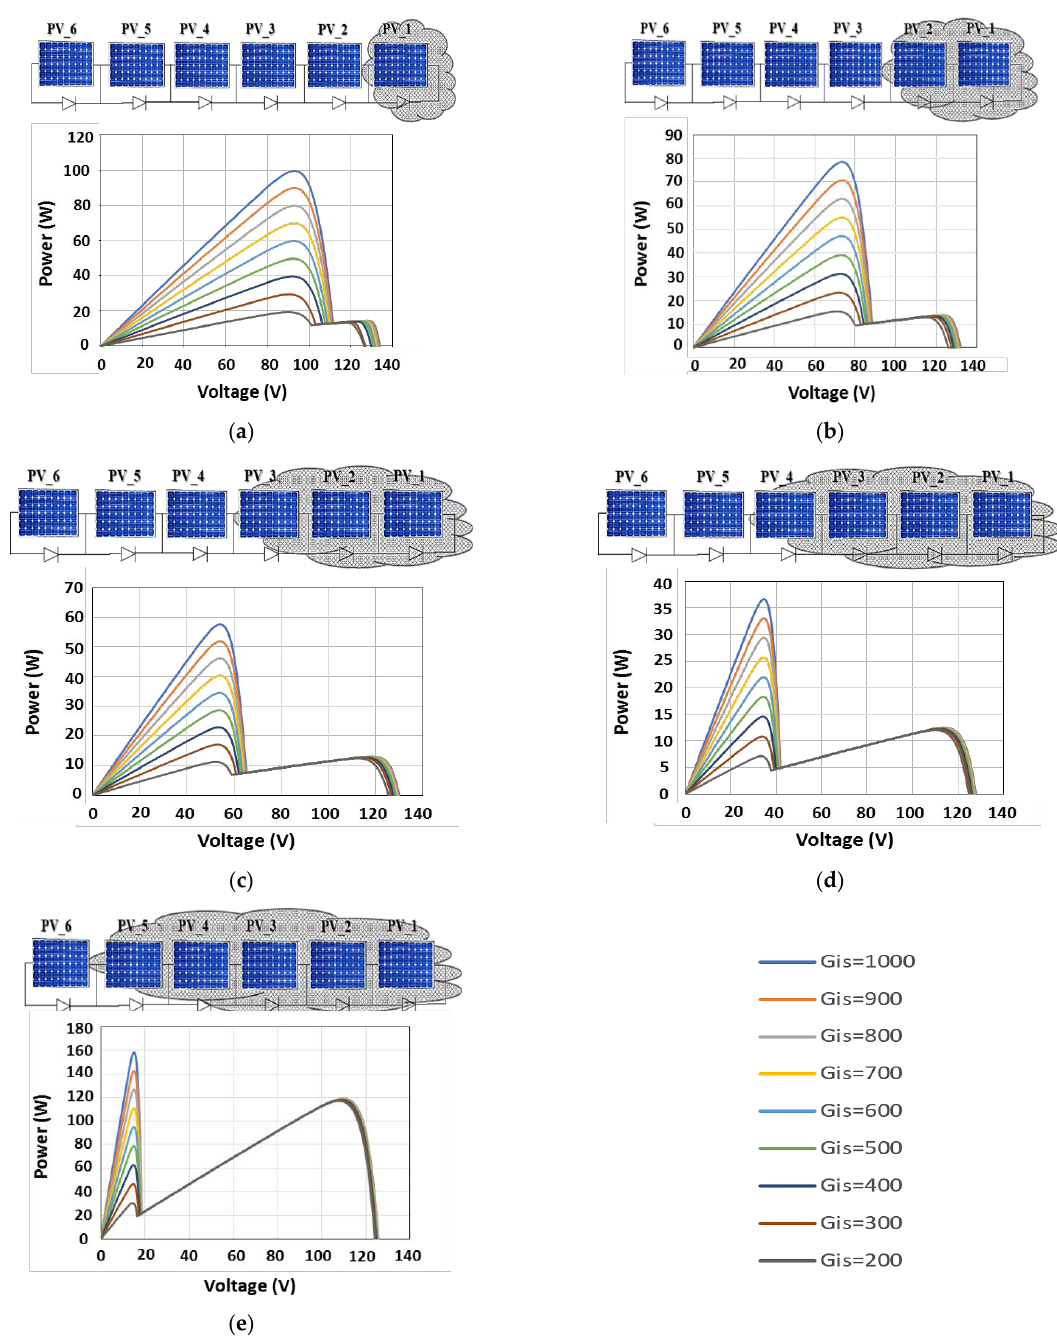
Figure 9. The P-V characteristic of the PV array for different shading scenario tests: ( a ) Test 1, ( b ) Test 2, ( c ) Test 3, ( d ) Test 4, ( e ) Test 5.